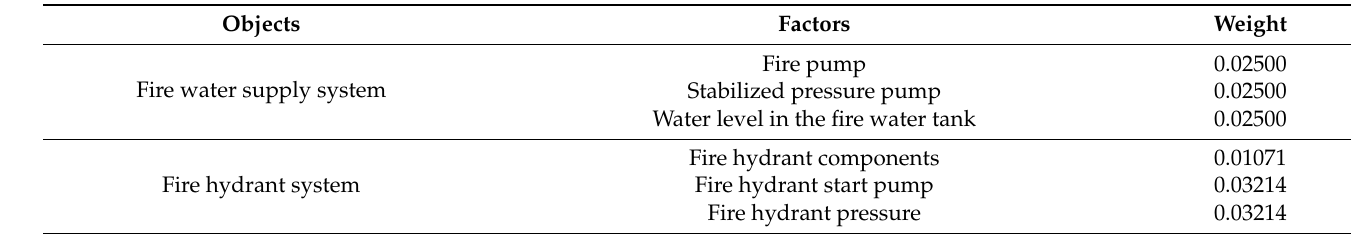
Table A2. The description and weight of each factor under the global factor of fire